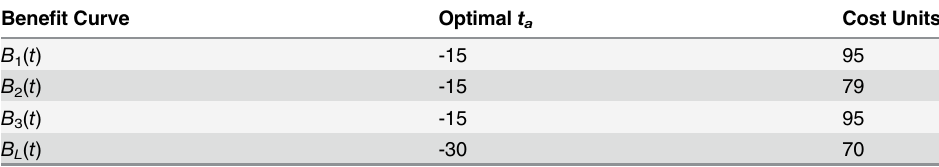
Table 1. Optimal arrival time with the corresponding cost for each benefit